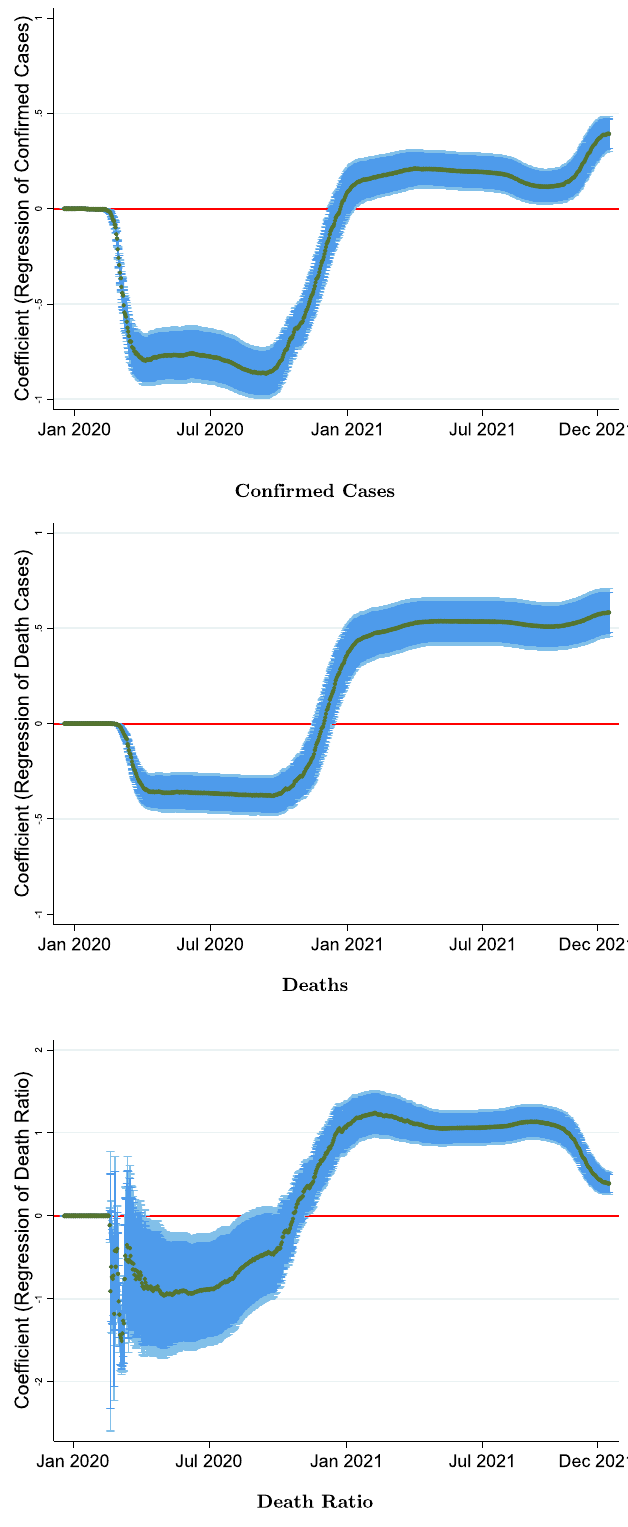
Fig. 3 Regression coef fi cients of COVID-19 variables on East for German districts. Daily regression coef fi cients (95 and 90% con fi dence interval) of con fi rmed cases, deaths and death ratio on East for all German districts (Berlin excluded), 2020 and